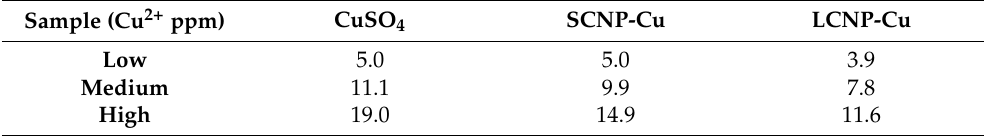
Table 1. Antimicrobial ppm concentration of copper used for MIC tests on L. monocytogenes (ATCC 19117). Sample (Cu 2+